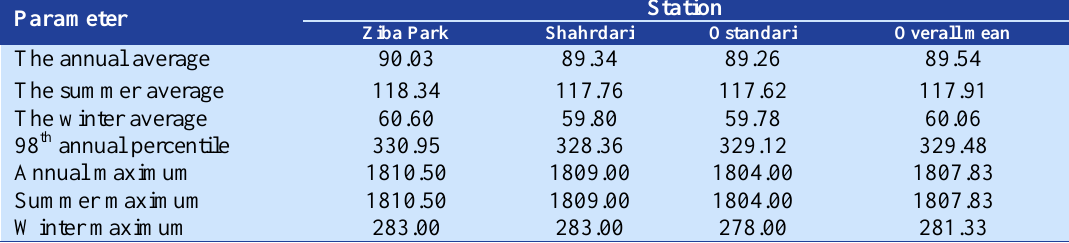
Table 1. The required indices of the model for PM Kermanshah in 2011